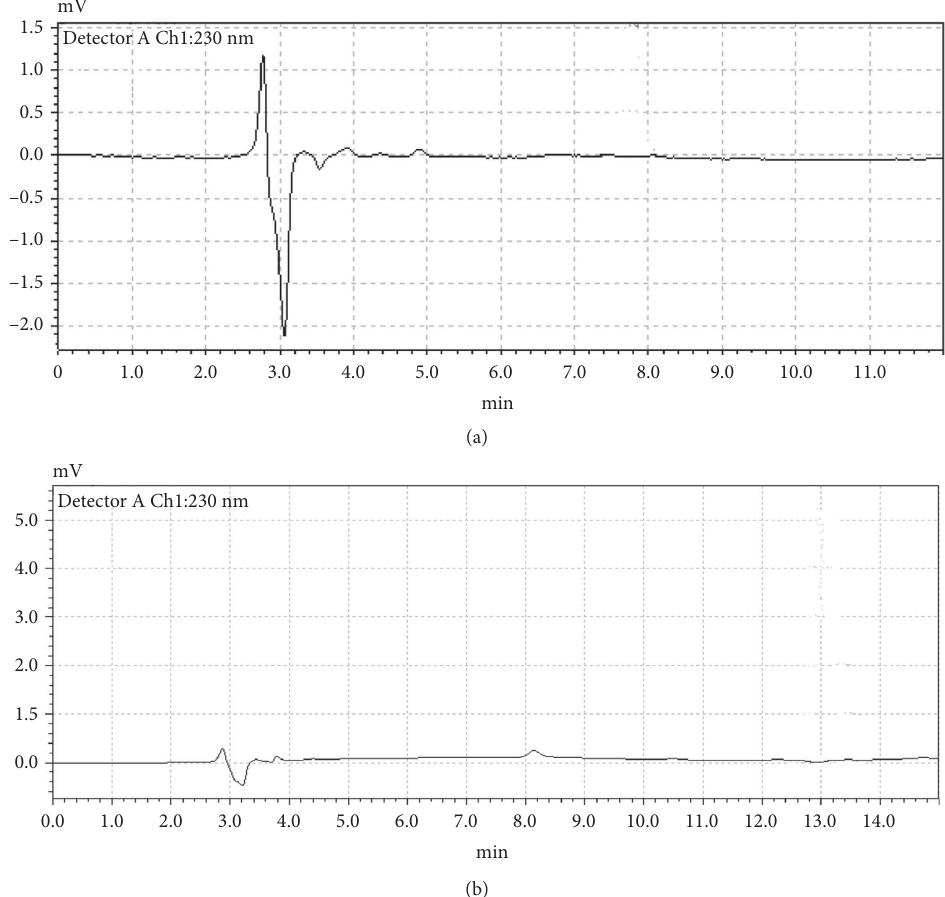
Figure 3: Chromatogram of blank of nonspiked chicken before (a) and after (b) cooking under the same conditions and